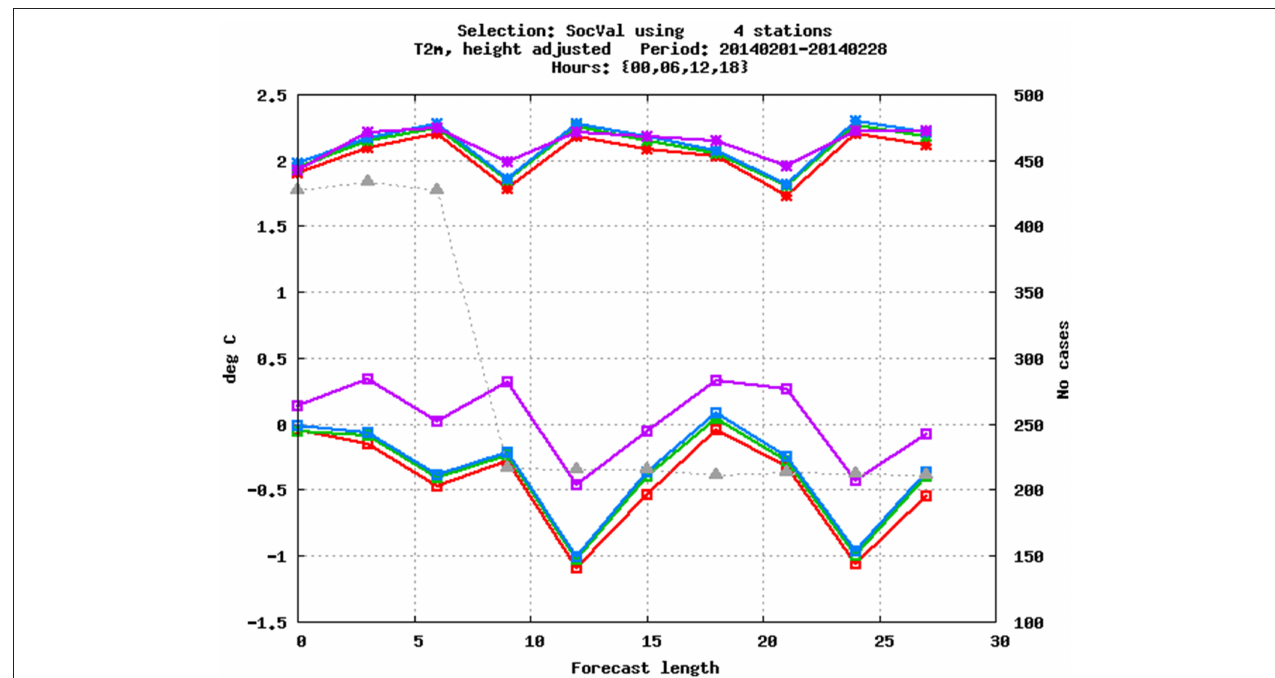
FIGURE 7 | Standard deviation (upper curves) and bias (lower curves) of the height-adjusted screen-level temperatures T 2 m as a function of forecast length (hours) against observations of the Olympic valley stations during February 2014: harcau0 (red), harcau6 (green), harcau8 (dark blue), soc38h12_15_nc (violet), number of cases (gray